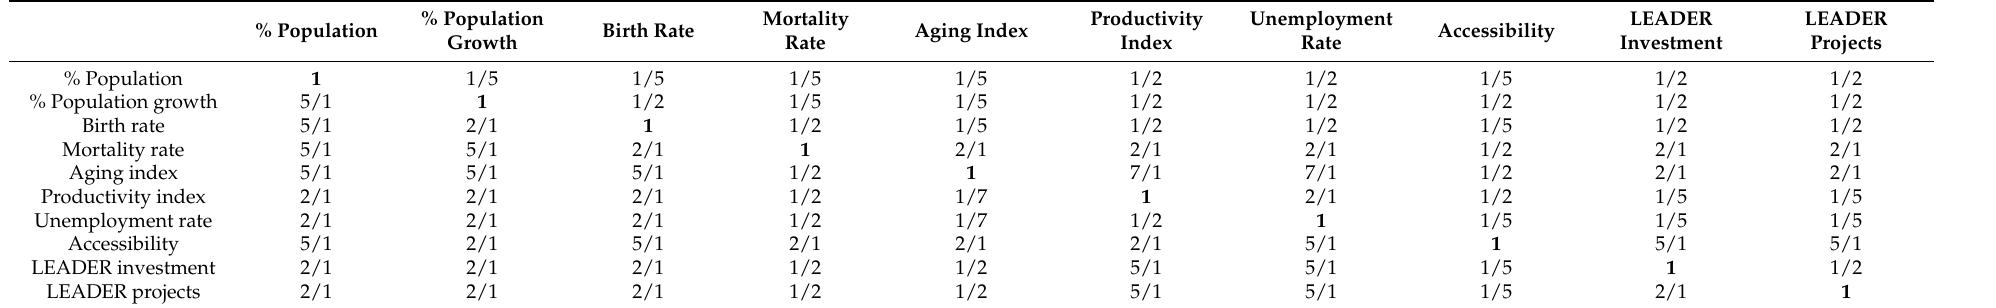
Table 4. Pairwise comparison matrix (PCM).